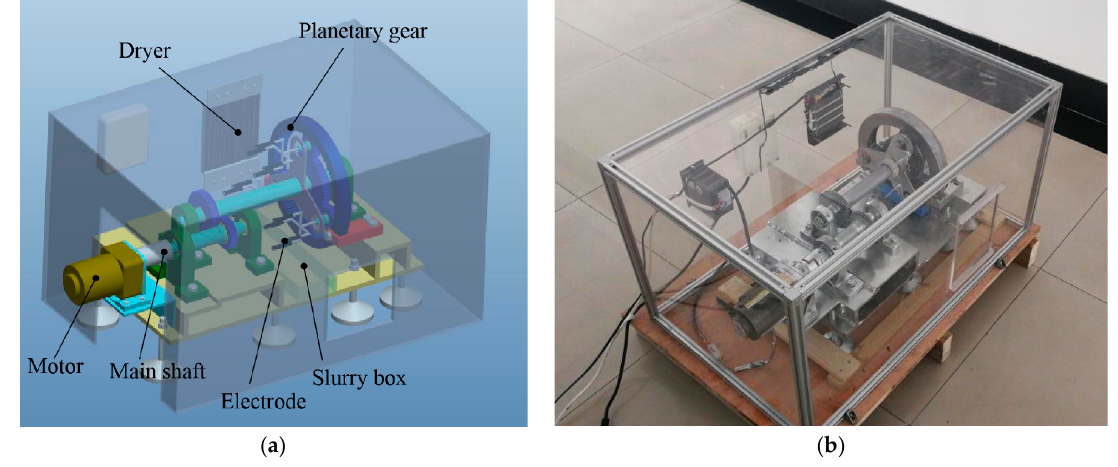
Figure 2. Coating device: ( a ) Three-dimensional design drawing of the device; ( b ) Physical picture of the